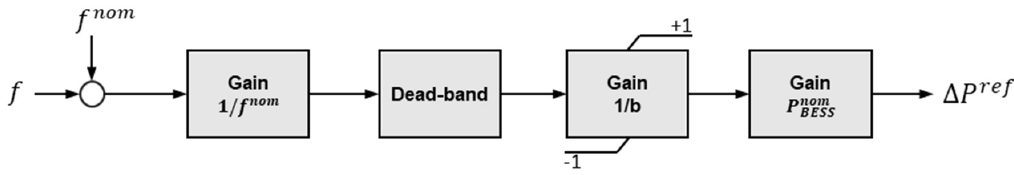
Figure 5. Frequency Controller model.